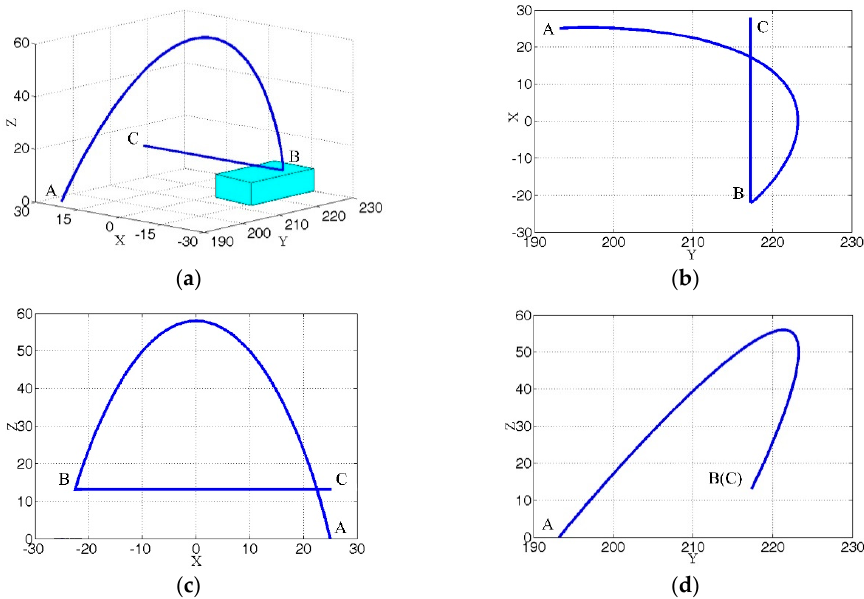
Figure 17. Foot trajectory simulation in MATLAB: ( a ) Adaptive foot-end trajectory in a cycle, ( b ) projection of trajectory in XY, ( c ) projection of trajectory in the XZ plane, and ( d ) projection of trajectory in the YZ plane [29].